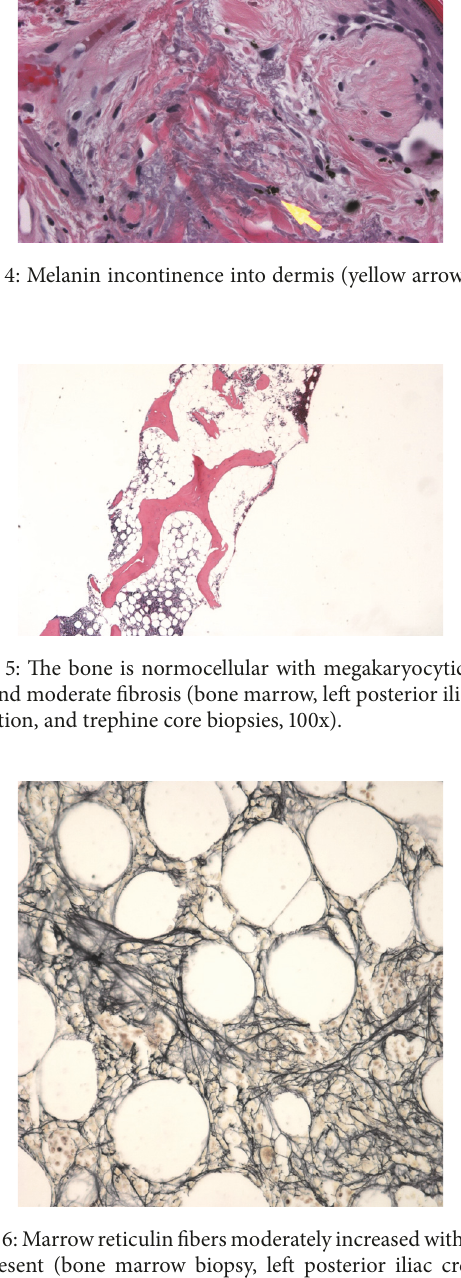
Figure 3: Vacuolar change due to basal cell degeneration (H&E 200x). Civatte bodies at the papillary dermis. Prominent perivascu- lar lymphocytes at left lower corner.